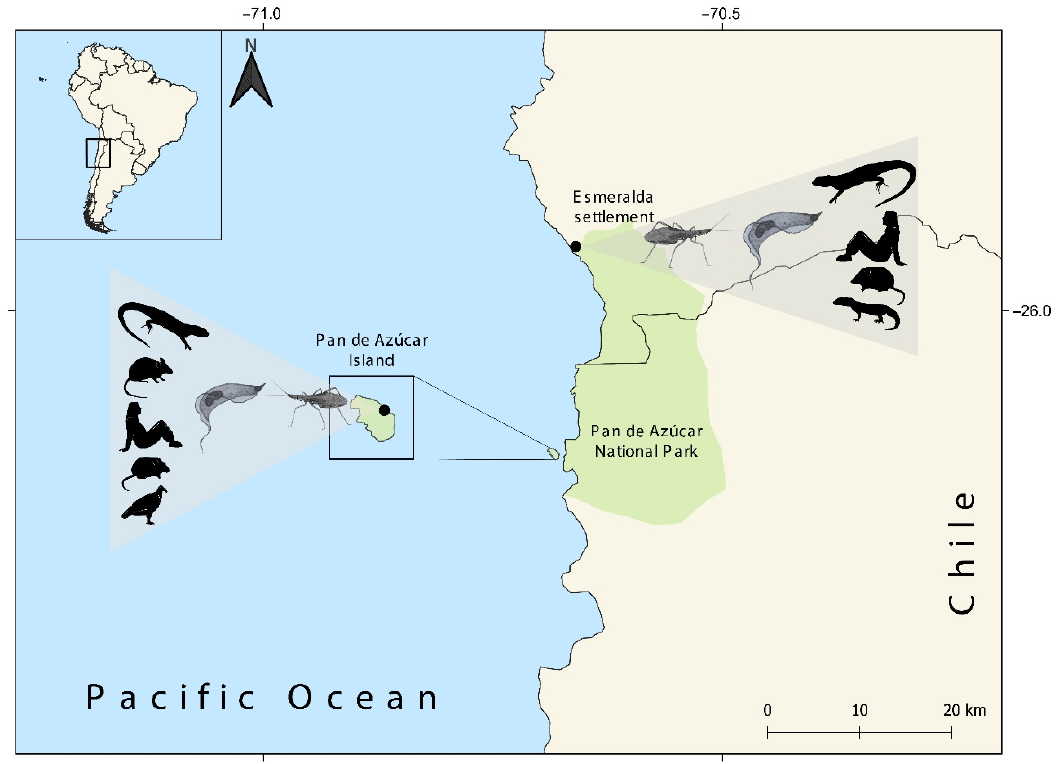
Figure 1. Map of Pan de Azúcar National Park (PANP) off the Pacific coast of southern South America. Black dots represent the study sites in Pan de Azúcar Island and the mainland (Esmeralda settlement). Five vertebrate species were detected in the island blood meal sources (left); from top to bottom: the lizard Microlophus atacamensis , the common mouse Mus musculus , Homo sapiens , the sylvatic mouse Abrothrix olivaceus and the vulture Cathartes aura . Four species were detected in the mainland blood meal sources (right); from top to bottom: M. atacamensis , H. sapiens , A. olivaceus and the gecko lizard Garthia gaudichaudii